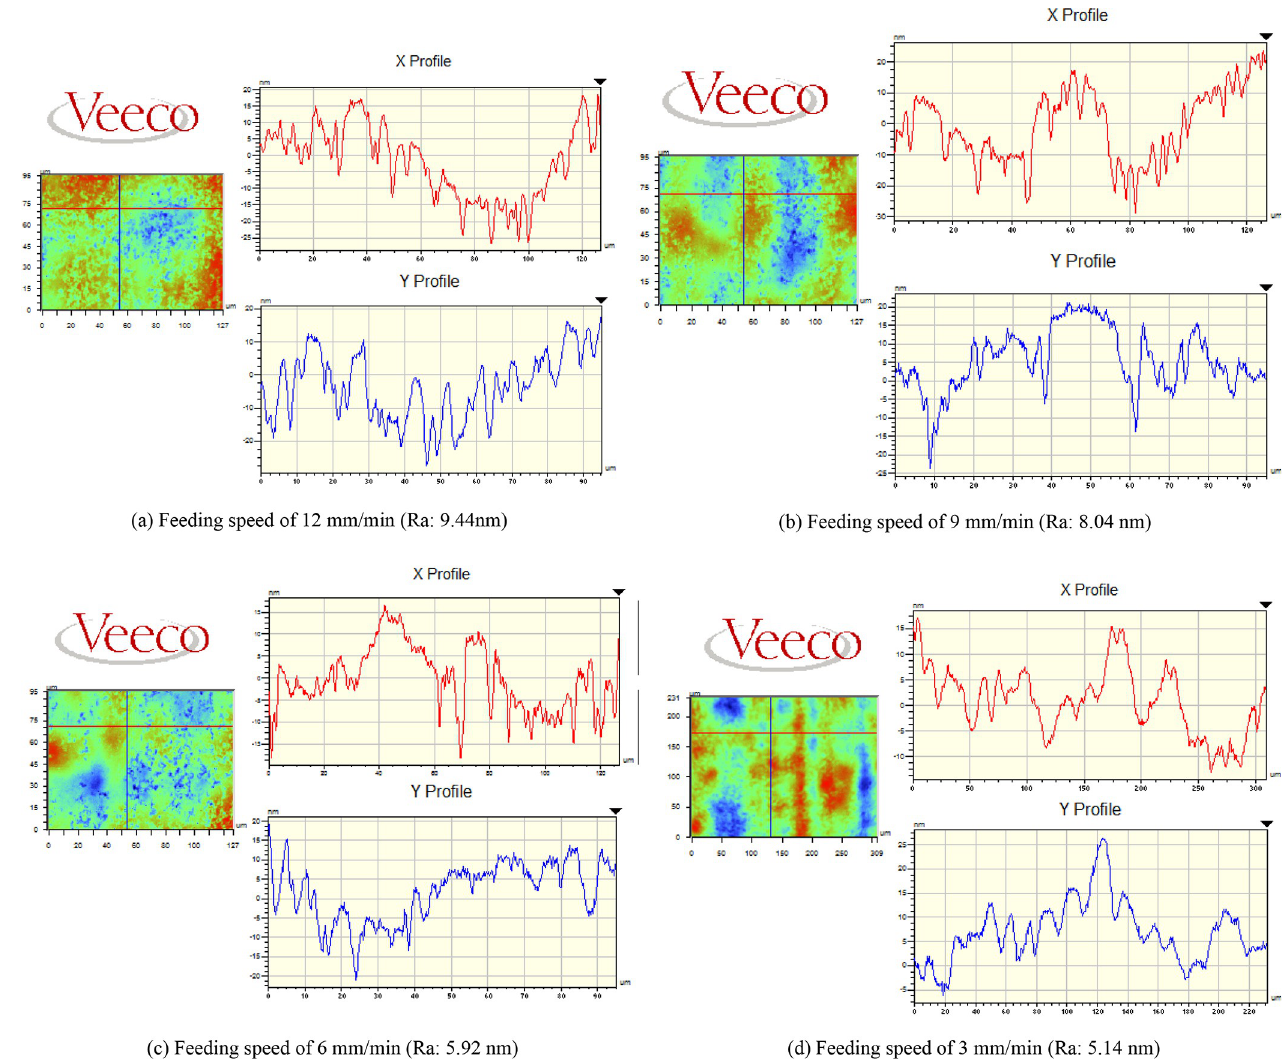
Fig 5. Roughness under different feeding